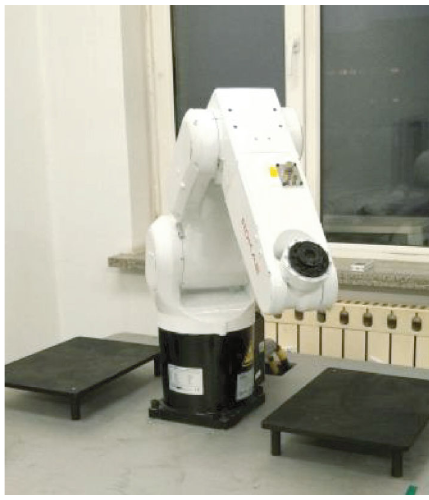
Figure 1: 6-DOF serial